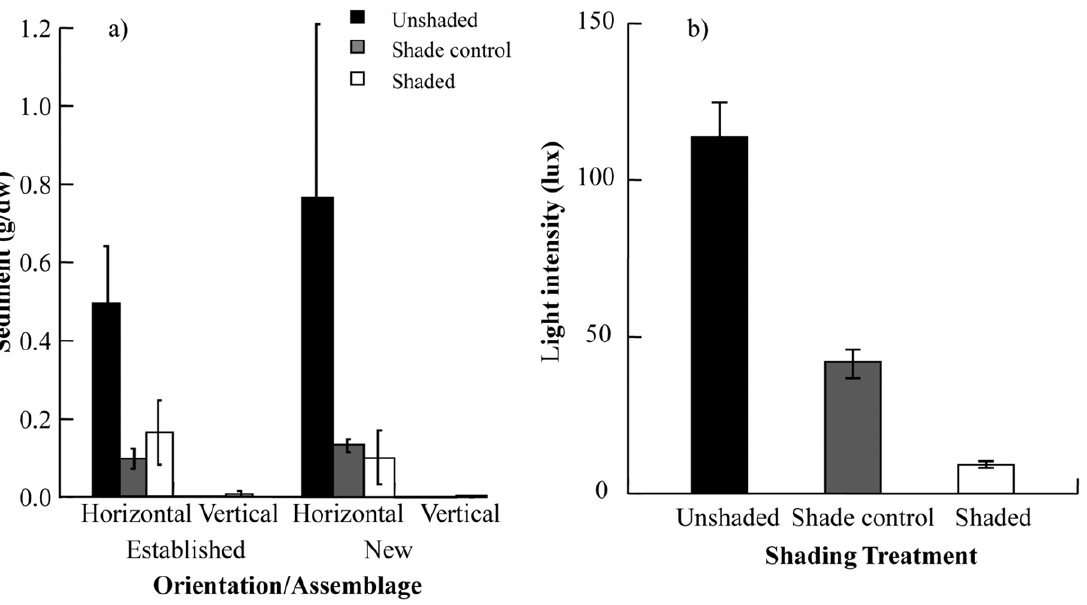
Figure 8. Sediment and light intensity collected during deployment of experimental ‘‘reef’’. (a) Sediment (g/dry weight) was collected from individual plates prior to final collection of plates and (b) light (lux) was sampled above the plates with loggers for 28 days during the experiment. The averages are presented for each measure and bars are separated by (a) orientation (horizontal or vertical) and assemblage (new or established) and (a/b) coded for shading treatment (unshaded, shade control or